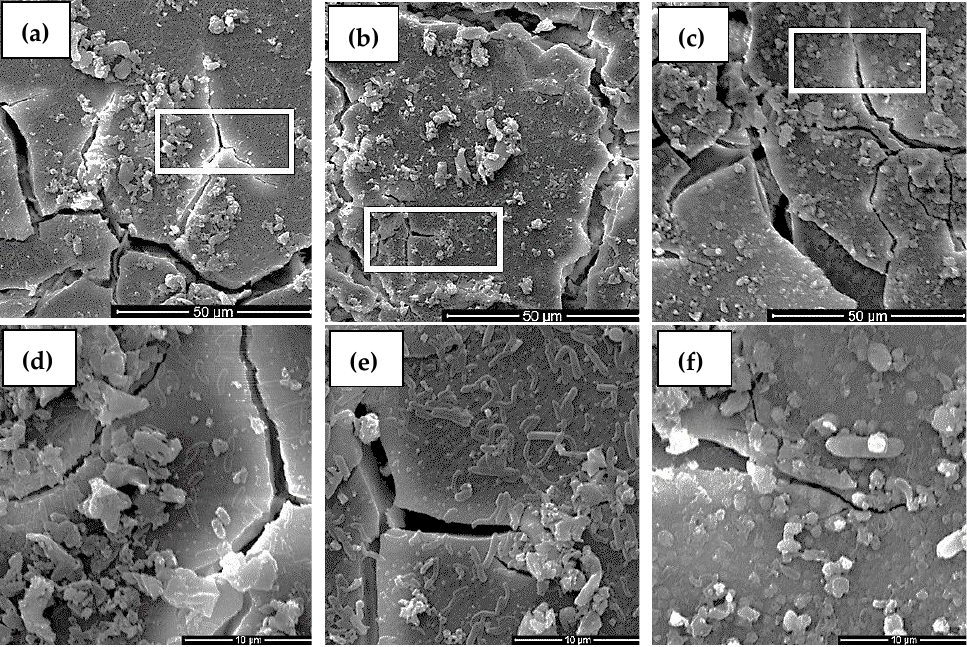
Figure 9. Morphologies of alloys immersed in SRB for 3 days: ( a ) Mg-1Nd alloy, ( b ) Mg-2Nd alloy, ( c ) Mg-3Nd alloy; local enlarged view of: ( d ) Mg-1Nd alloy, ( e ) Mg-partial, ( f ) Mg-3Nd alloy.